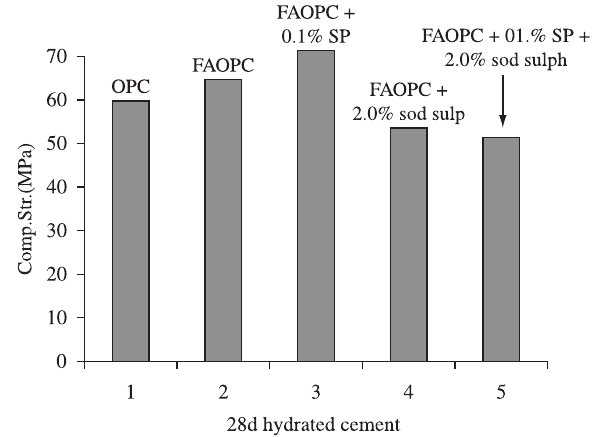
Figure 7. Compressive strength in different systems at 28 days of hydration.